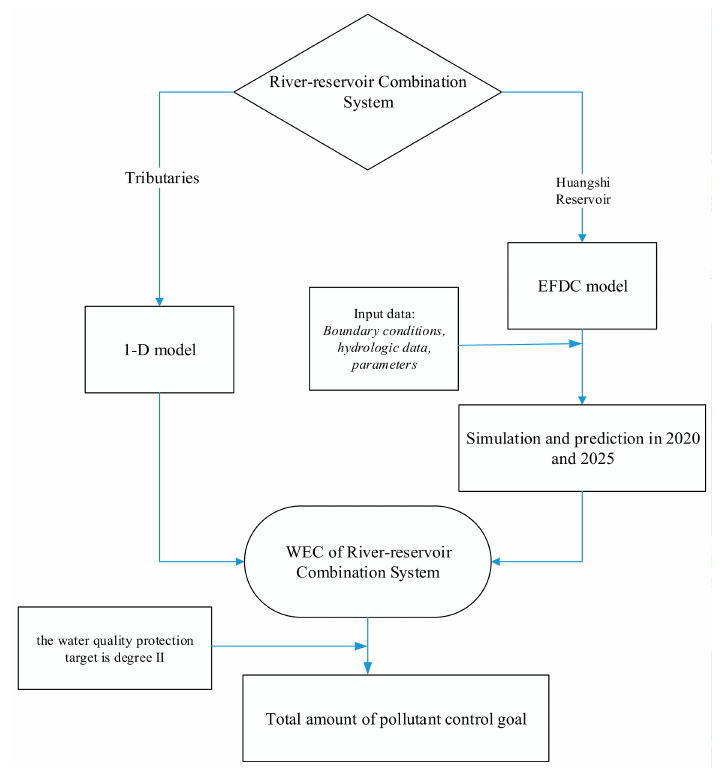
Figure 3. The technical